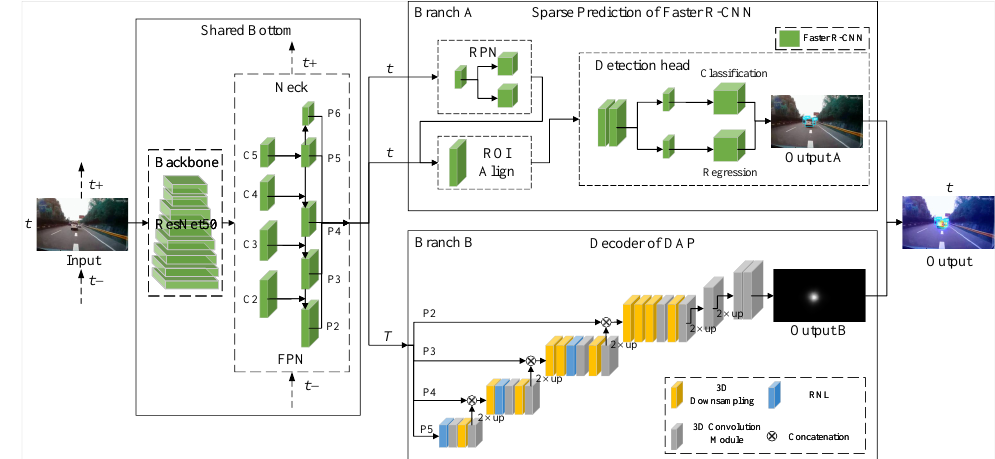
Figure 5. Overview of SOE-F, where t represents the current frames, t − denotes the historical frames, t + represents the future frames, and T denotes the number of consecutive frames. C ∈ { C 2, C 3, C 4, C 5 } and P ∈ { P 2, P 3, P 4, P 5 } represent different feature levels in